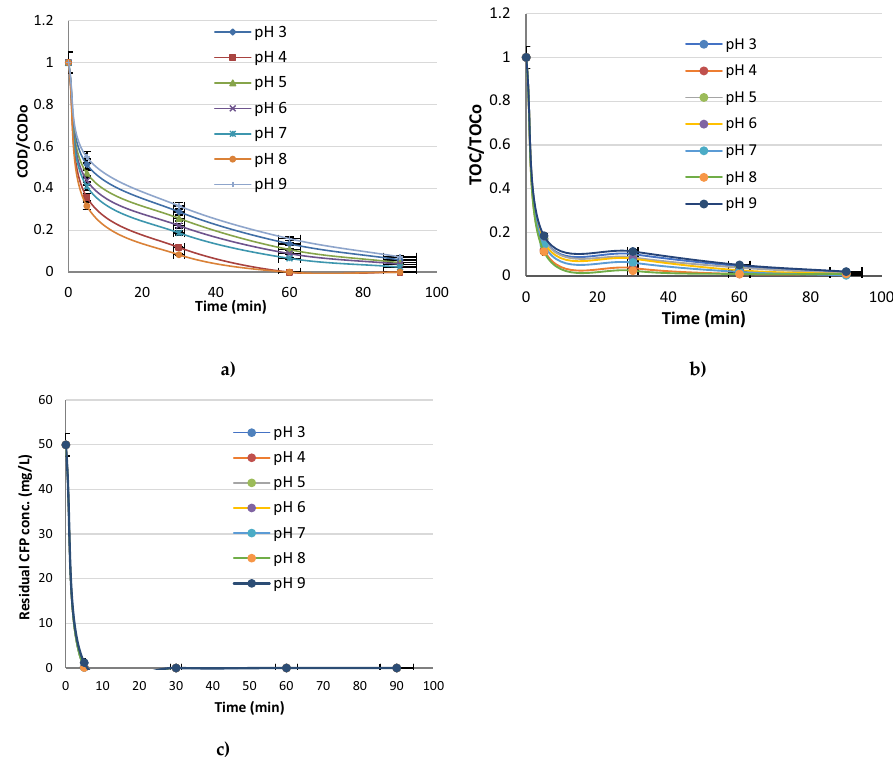
Figure 5. Effect of pH on ( a ) COD/COD o , ( b ) TOC/TOC o and ( c ) Residual CFP conc. (KCl conc.: 750 mg/L, I: 50 mA/cm 2